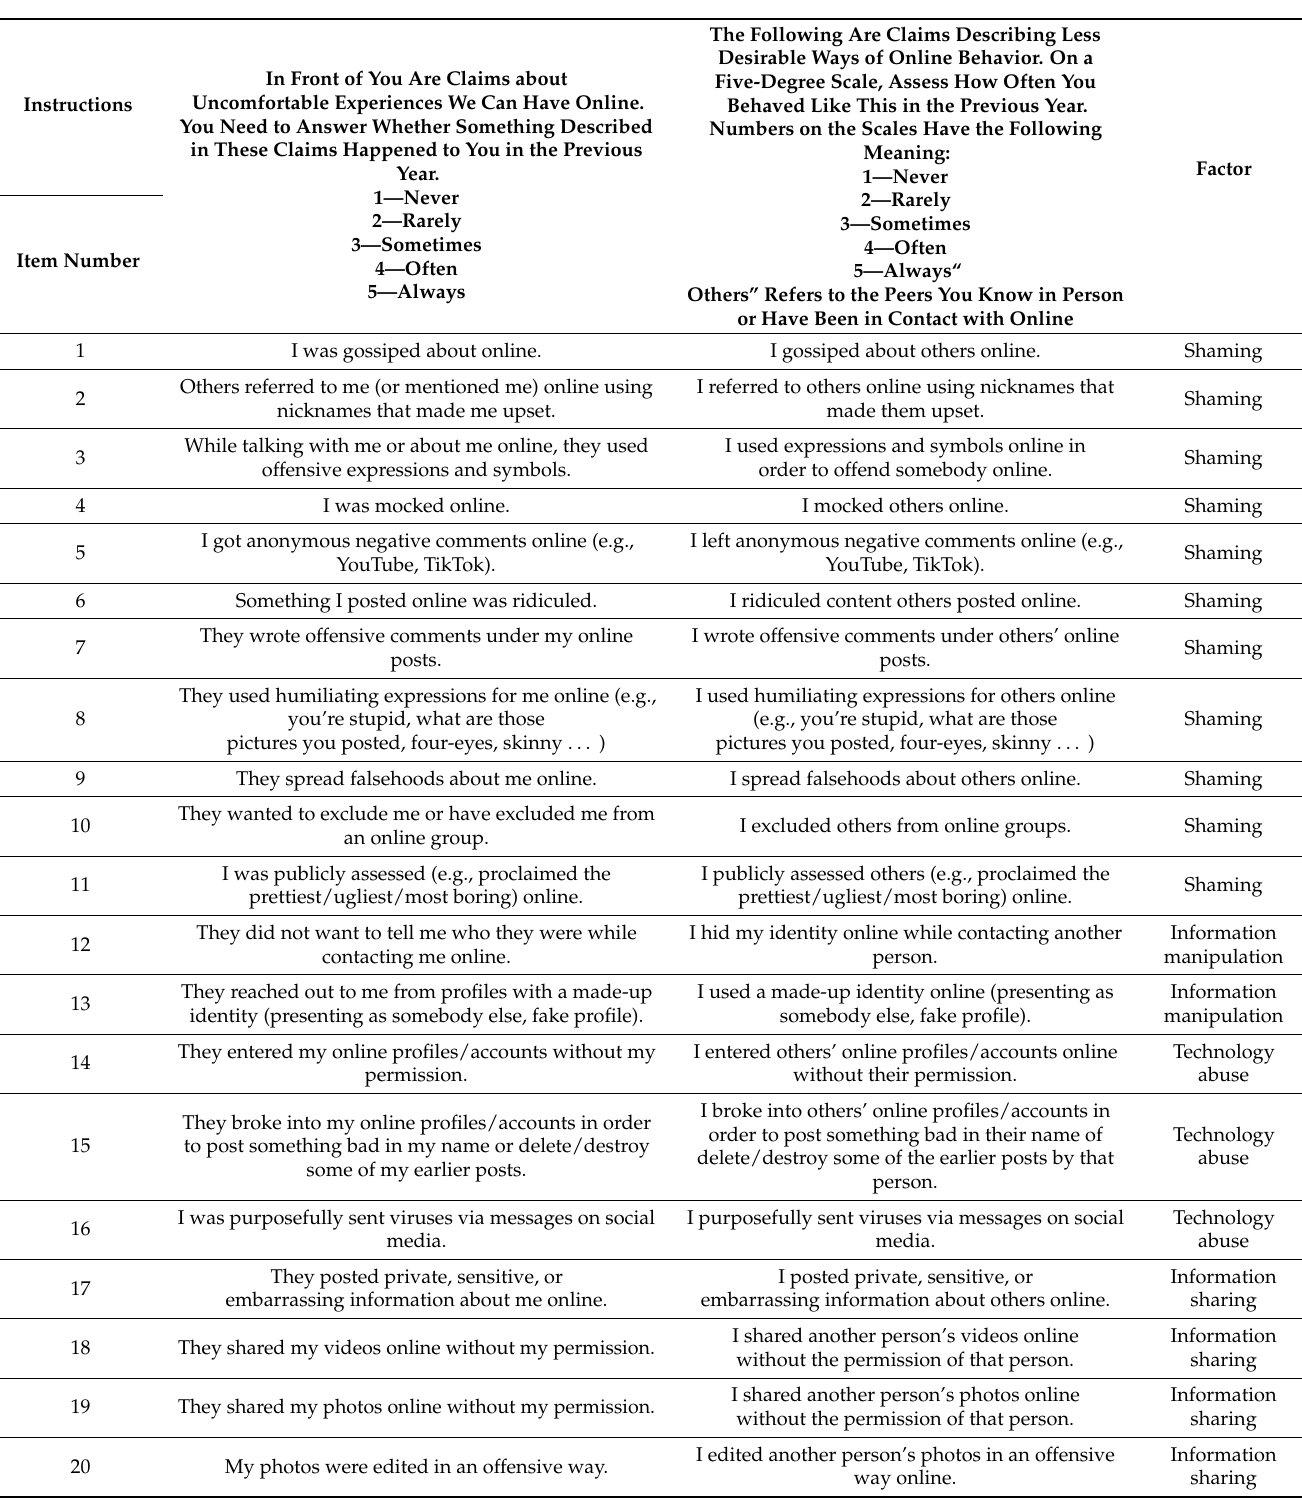
Table A1. The Committing and Experiencing Cyber-Violence Scale—2021 (CECVS-2021, Šincek, 2021). Translation is only for informative purposes; it is not translated per standard procedure for